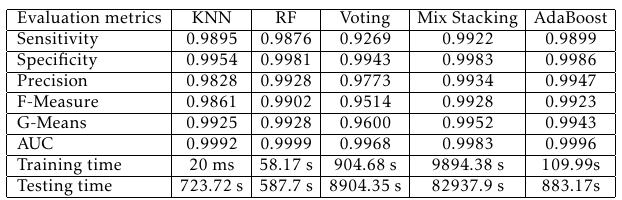
Table 7. Compare results of algorithms when classifying DoS on